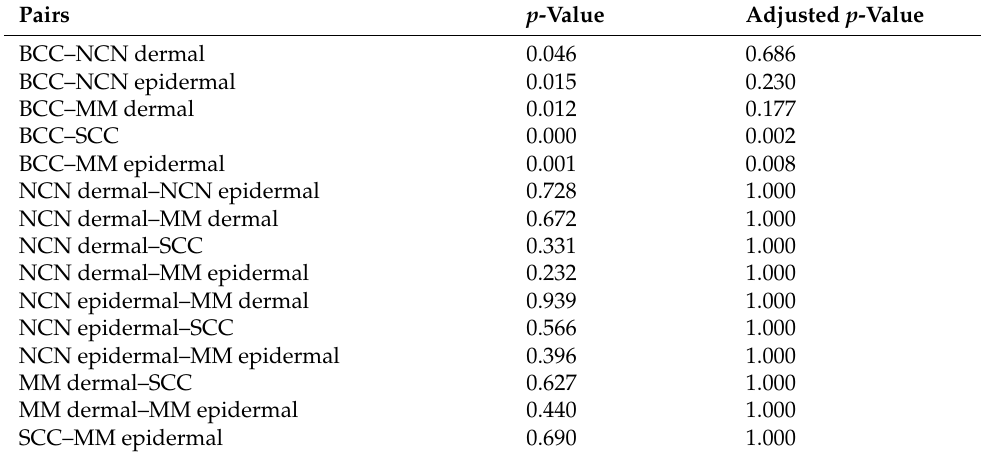
Table 1. Statistical analysis of TRPC4—comparison of all